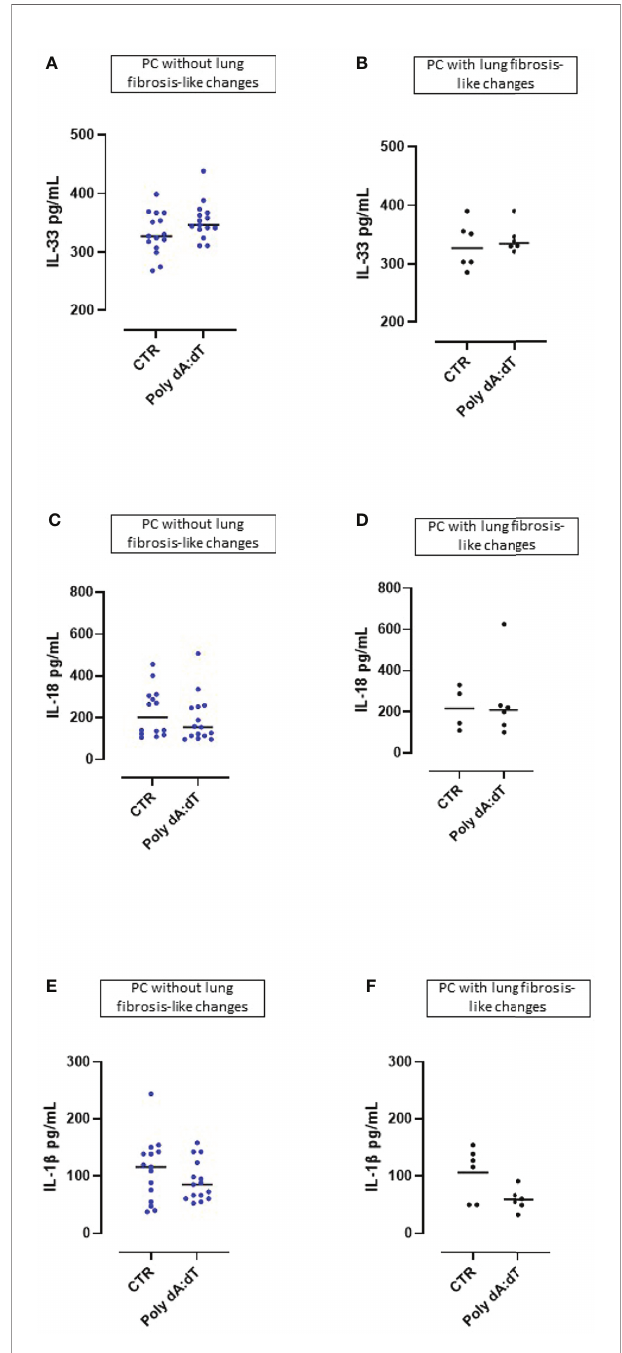
FIGURE 3 | AIM2 receptor activation did not induced the release of in fl ammasome-associated IL-1-like cytokines from Post-COVID-19 patients with or without fi brosis. Stimulation with Poly dA:dT (1 m g/mL) for 5 hours did not induce the release of (A, B) IL-33, (C, D) IL-18 or (E, F) IL-1 b from Post- COVID-19 (PC) PBMCs from patients without (A, C, E) or with (B, D, F) signs of lung fi